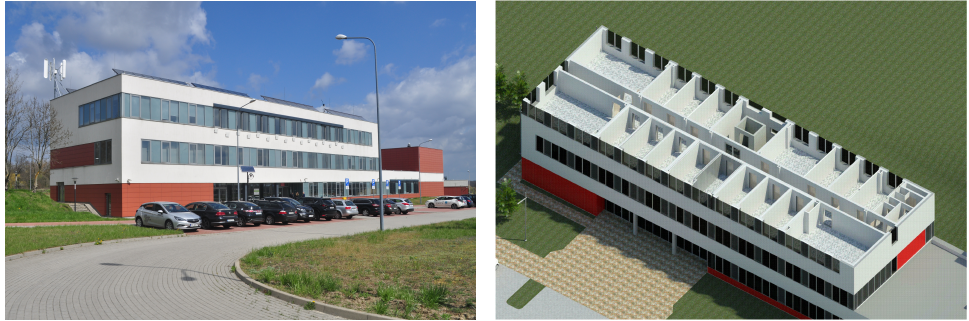
Figure 1. Center for Sustainable Building and Energy in The Science and Technology Park in Nowy Kisielin, Poland; view of the building facade and horizontal